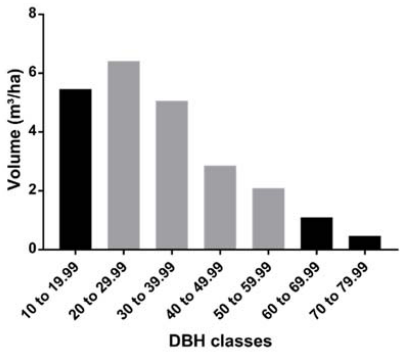
Figure 6. Total volume per hectare by DBH classes (cm) of the Eschweilera genus in the N-S/E-W transects. The gray columns highlight the DBH classes (cm) to concentrate the forest management in order to focus on the sustainability of the Eschweilera genus.